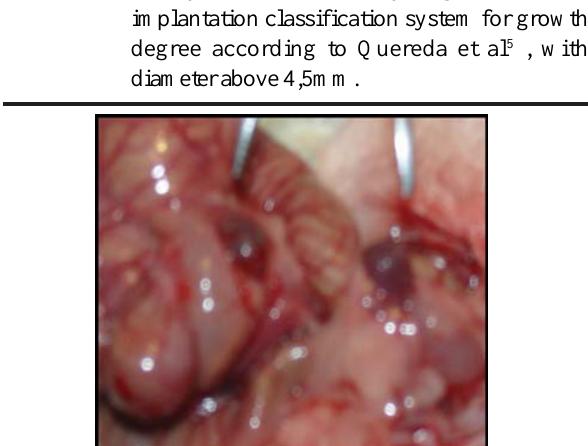
FIGURE 5 - Photomicrography of self-transplantation degree II for growth degree according to Quereda et al5, showing the occurrence of two focus from one single patch